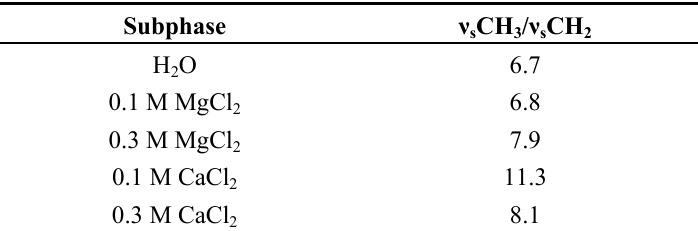
CH / ν CH mode ratio for various s 3 s 2